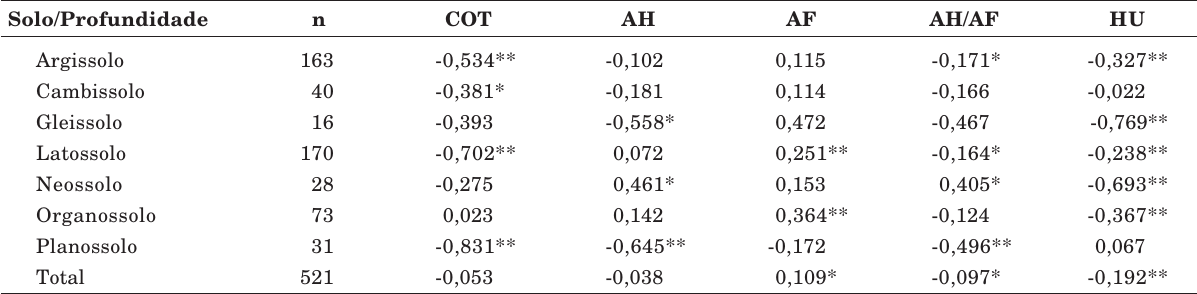
* e ** significativo a 0,05 e 0,01,